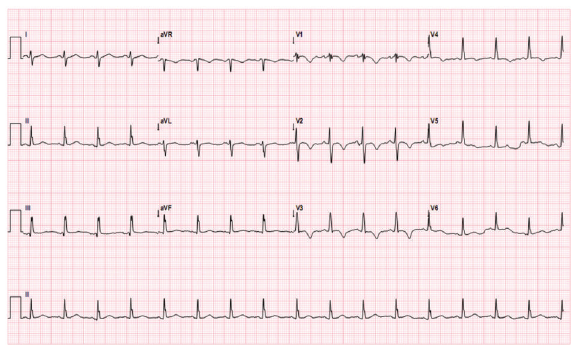
Figure 1: Electrocardiogram showing T-wave inversion in leads III and V1–4.